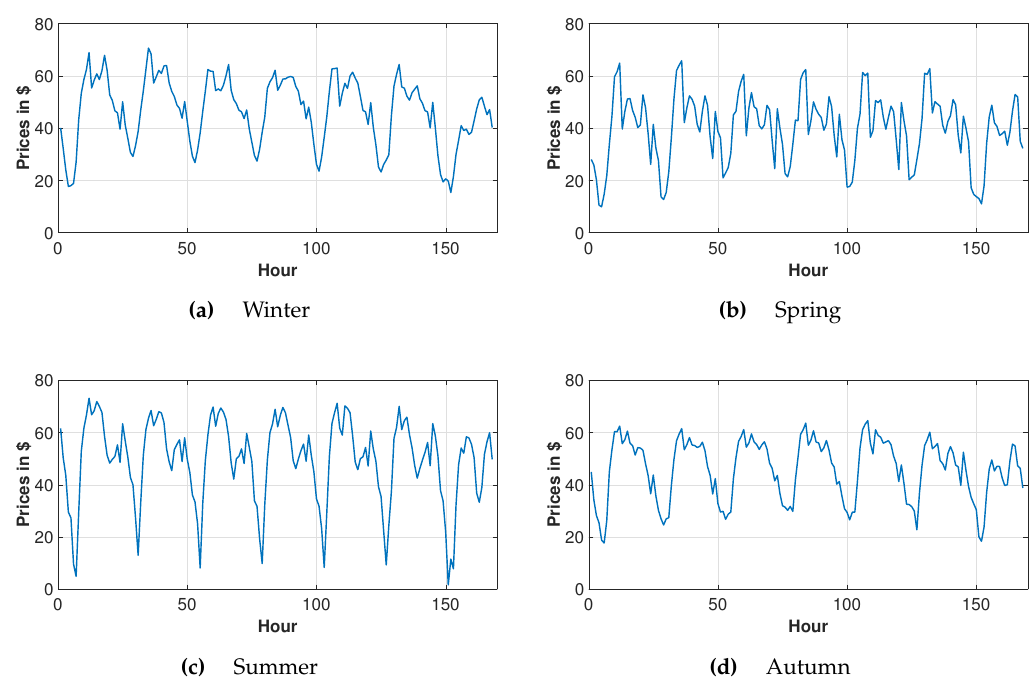
Figure 1. Hourly averaged electricity prices for each season of 2016. Table 1. Descriptive Statistics of the Turkish Day-Ahead Electricity Prices (Dollars/MWh) According to the Hours of the